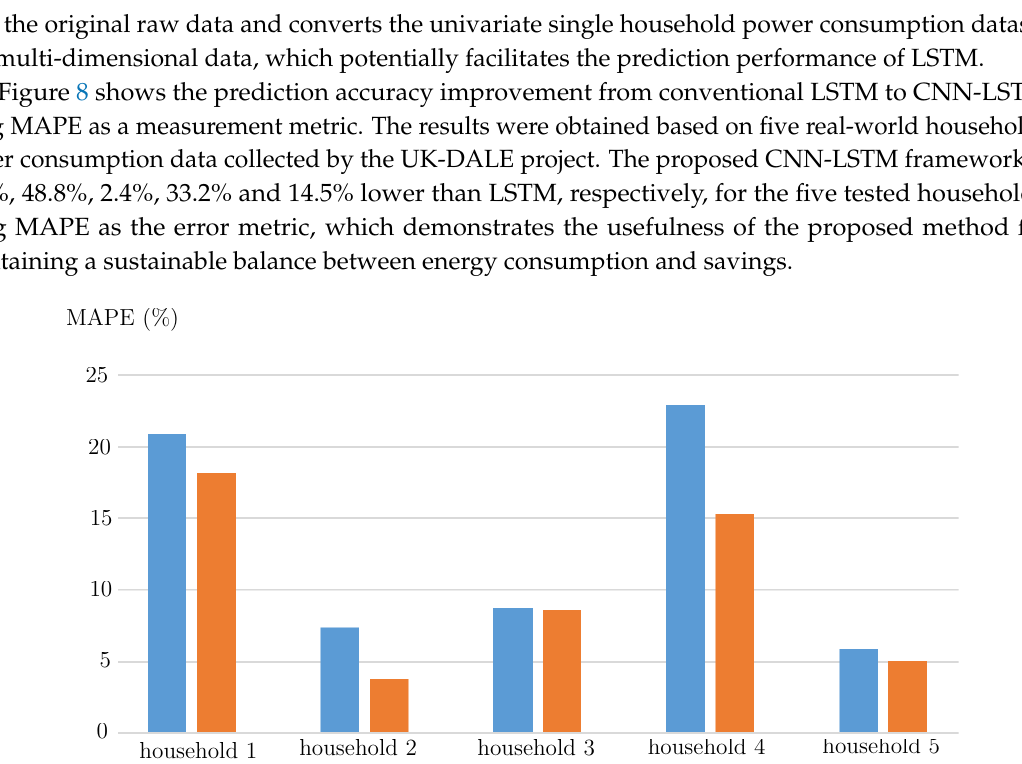
Figure 8. Experimental result comparison between LSTM and CNN-LSTM using MAPE as an error